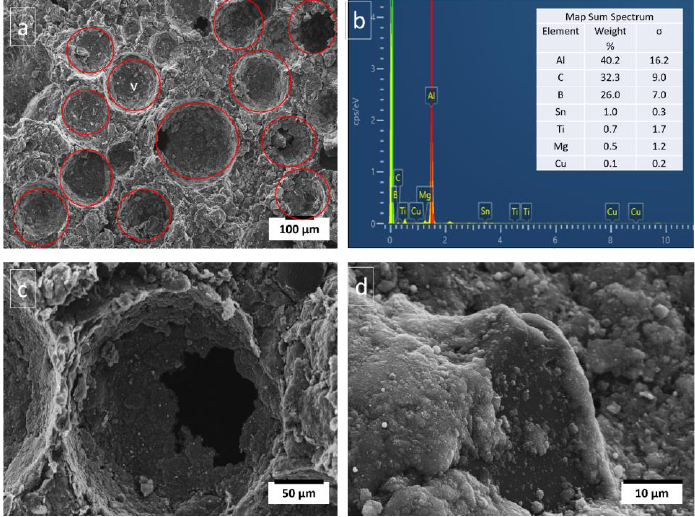
Figure 2. Microstructure of porous Al composite, ( a ) pore distribution and shape, ( b ) EDX of com- posite cross section, ( c ) pore cell and pore connectivity, and ( d ) well bonded diamond particle.